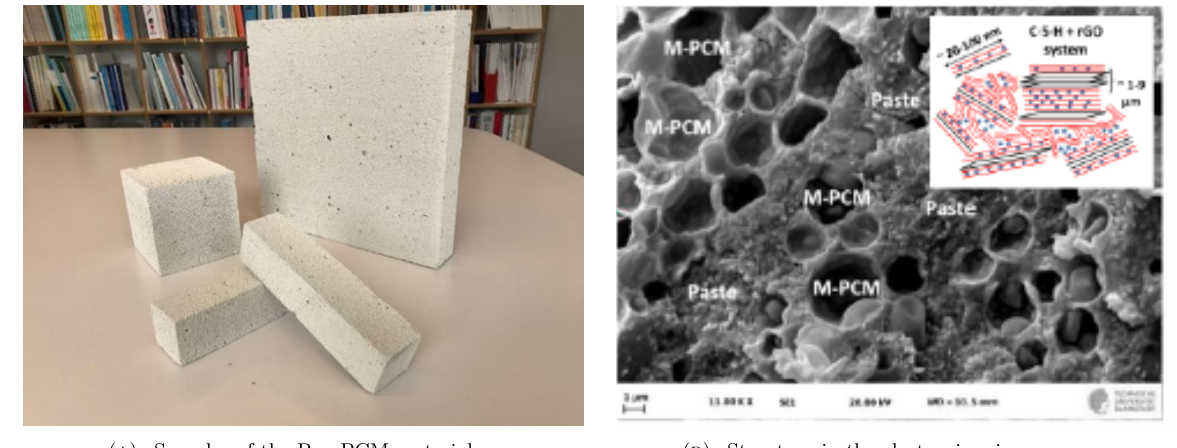
Figure 1. PoroPCM material samples and detail of the structure.